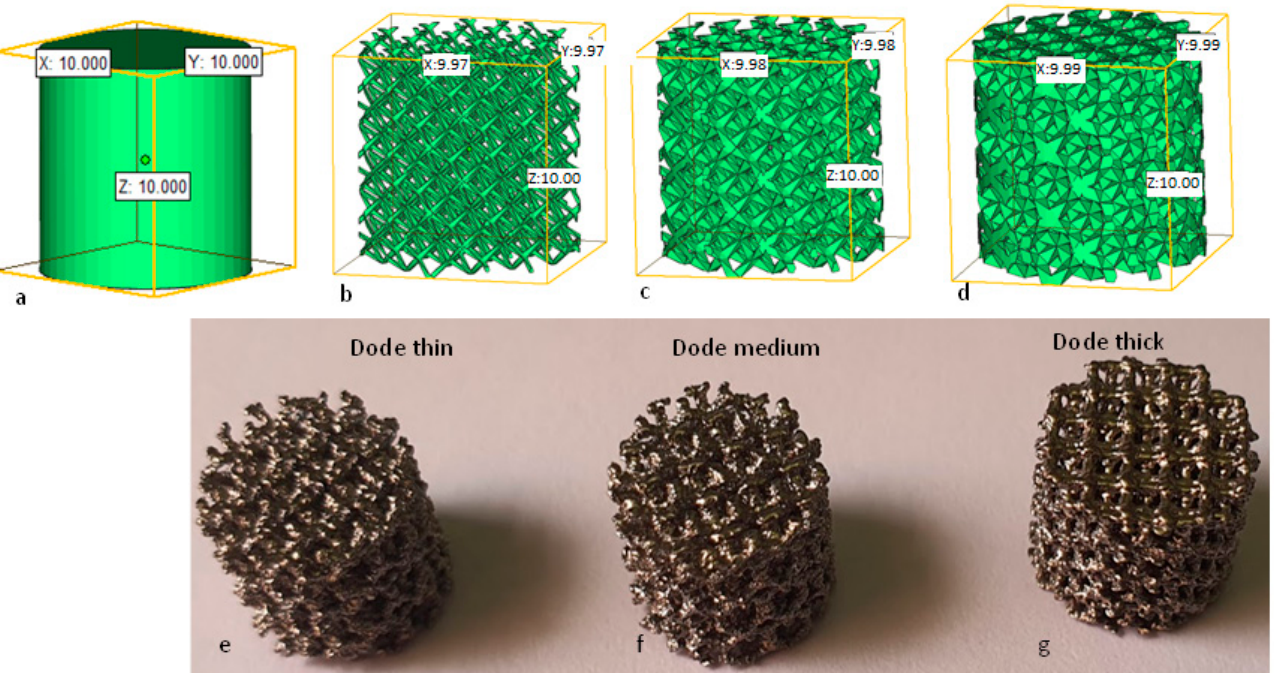
Figure 7. ( a ) A custom-designed cylinder of 10 × 10 mm 2 , and its transformation into three scaffold structures of ( b ) dode thin, ( c ) dode medium, ( d ) dode thick, and its counterpart ( e – g ) EBAM-fabricated scaffolds.